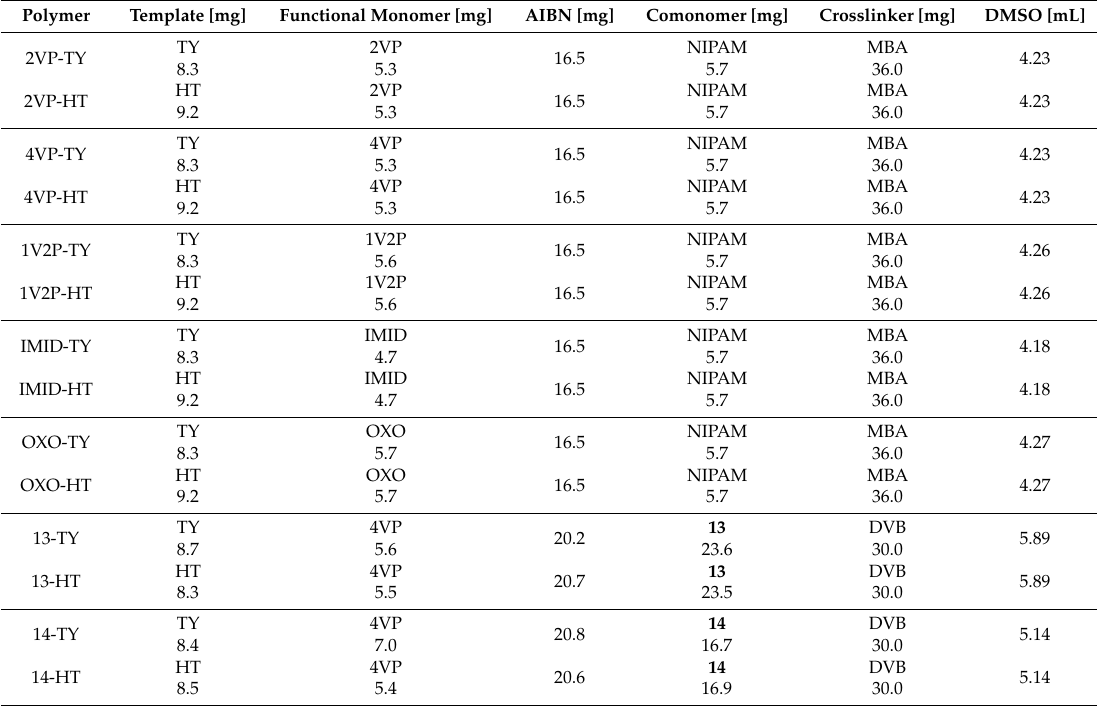
Table 1. Composition of the polymerization mixtures for monomers 5 – 9 and 13 – 14